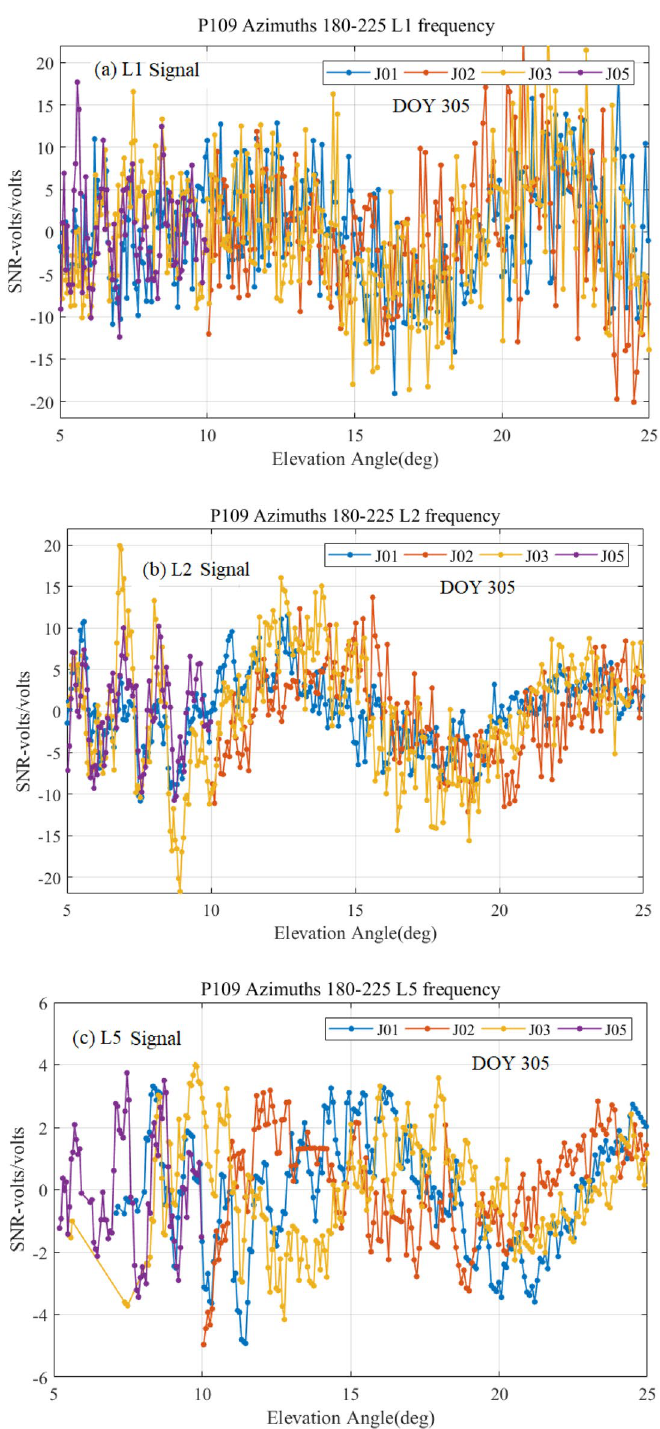
Figure 4. SNR (volts/volts) observation plots with respect to the elevation angles for ( a ) L1 signal, ( b ) L2 signal, and ( c ) L5 signal on the day of November 2019 (DOY